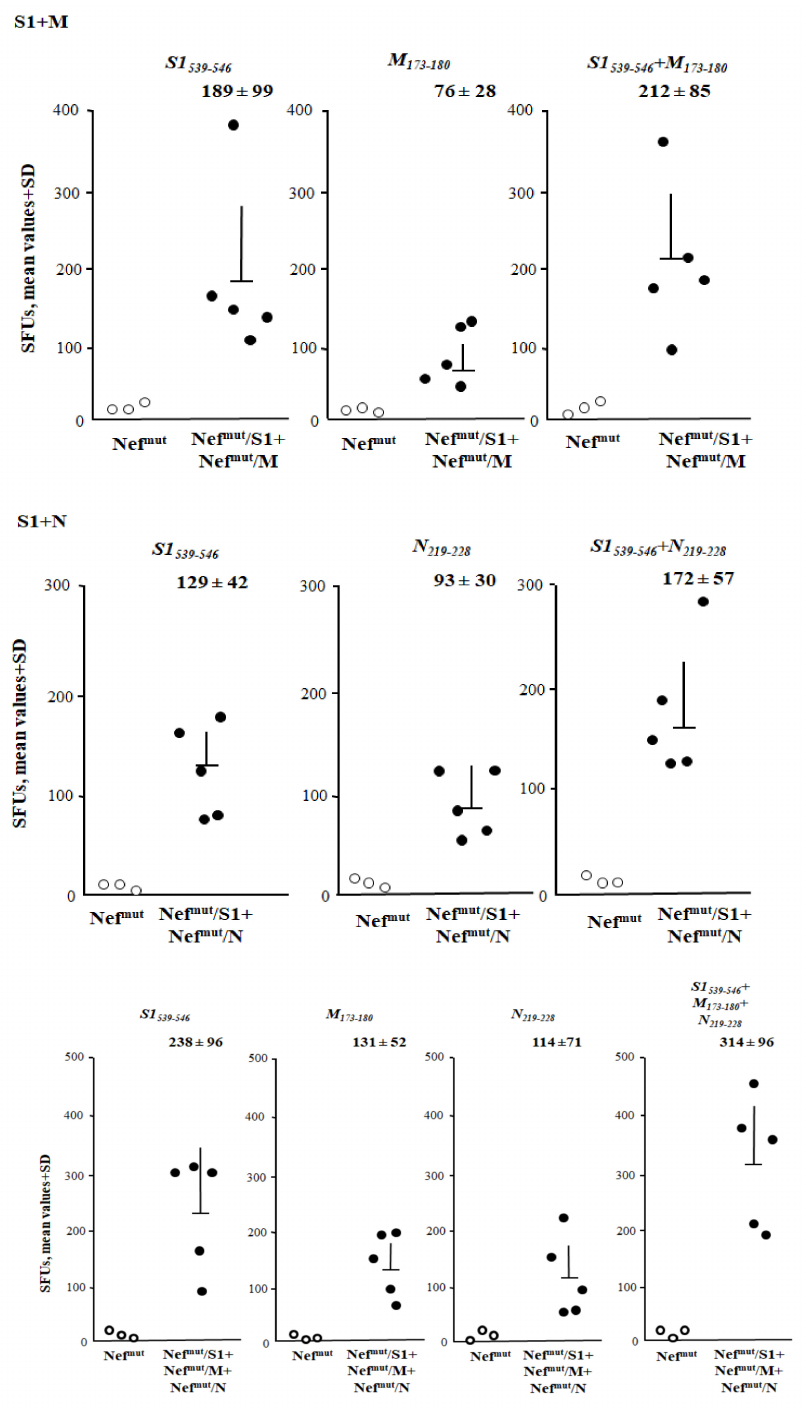
Figure 6. SARS-CoV-2-specific CD8 + T cell immune responses induced in spleens from mice immunized by combination of Nef mut -based DNA vectors. CD8 + T cell immune response in C57 Bl/6 mice inoculated i.m. with either the DNA vector expressing Nef mut alone (3 mice) or the indicated combinations of vectors expressing Nef mut fused with the SARS- CoV-2 antigens (5 mice per group). The CD8 + T cell immune responses were measured using the indicated peptides and combination thereof. At the time of sacrifice, 2.5 × 10 5 splenocytes were incubated overnight (ON) with or without 5 µ g/mL of either unrelated or SARS-CoV-2-specific peptides in triplicate IFN- γ EliSpot microwells. Shown are the numbers of SFU/well calculated as mean values of triplicates after subtraction of mean values measured in wells of splenocytes treated with unspecific peptides. Reported are intragroup mean values + standard deviations also. Circles sign values measured in cultures of splenocytes isolated from each injected mouse The results are representative of two independent